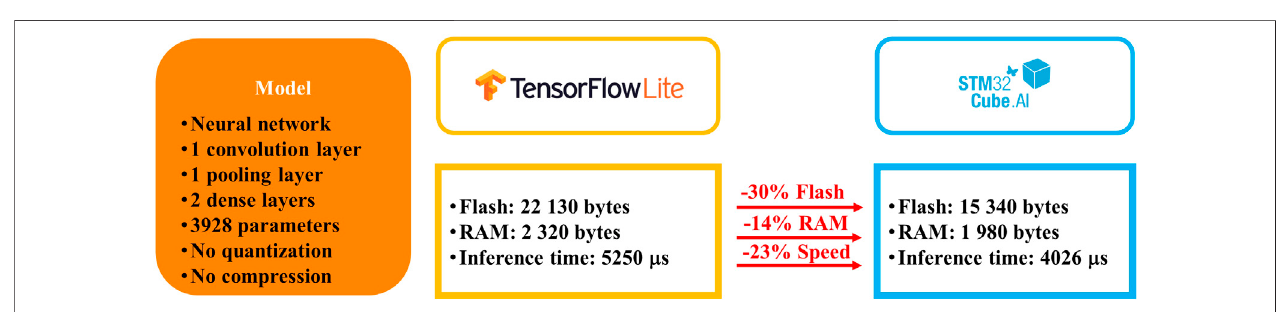
FIGURE 14 | Comparison of results using a model converter (TensorFlow Lite) and code generator (Cube.AI).